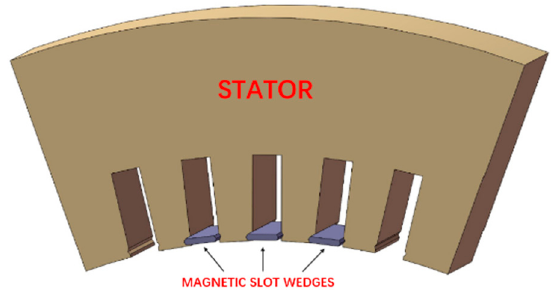
Figure 12. Stator core and MSW.